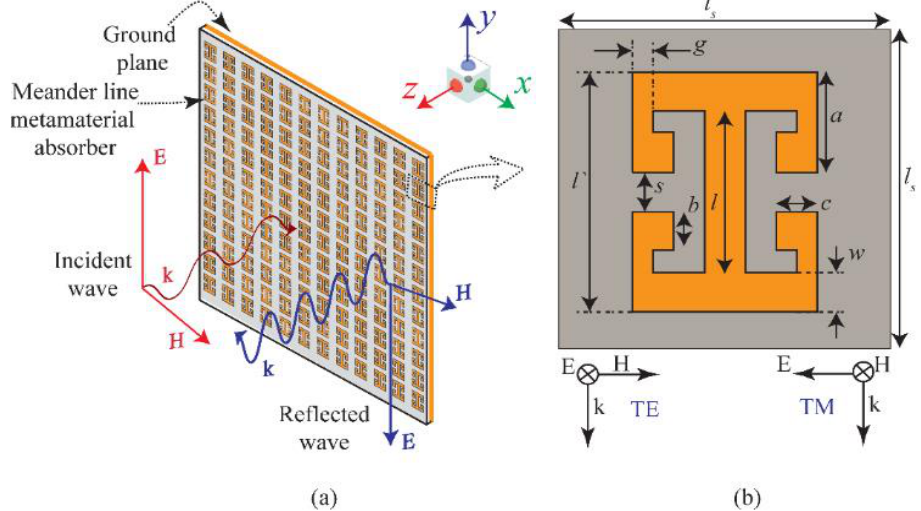
Figure 1. ( a ) Schematic representation of the finite absorber sheet consisting of the proposed meander-line-based 5G absorber. ( b ) Layout of the unit cell having optimized values as l s = 8 mm, l ′ = 6 mm, l w = 4.5 mm, l = 4 mm, w = 1 mm, a = 1.5 mm, b = 1 mm, c = 1 mm, g = 0.5 mm, and s = 1 mm.